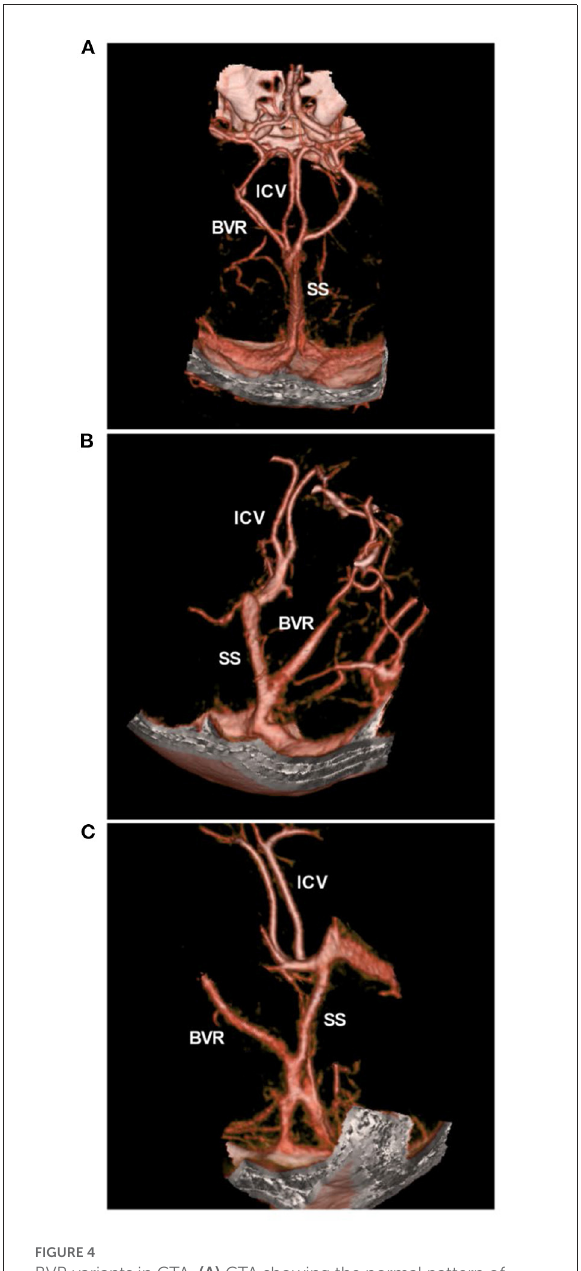
FIGURE4 BVR variants in CTA. (A) CTA showing the normal pattern of deep veins, bilateral ICVs and BVRs that flow into the vein of Galen. (B,C) CTA showing the BVR that flowed into the straight sinus. BVR, Basal vein of Rosenthal; CTA, computed tomography angiography; ICV, internal cerebral vein, SS, straight sinus.